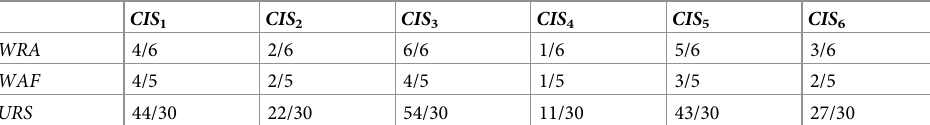
Table 4. Uniform ranking